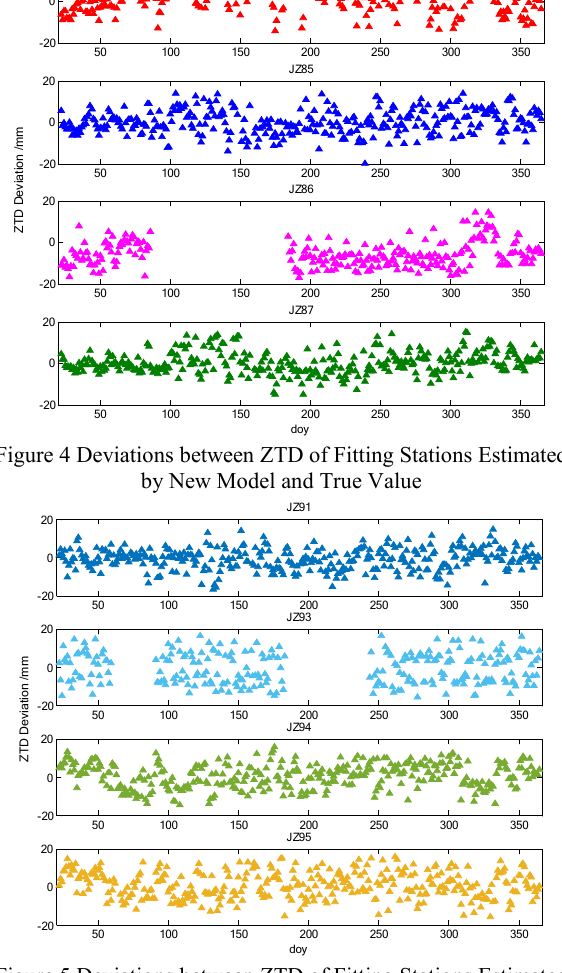
Figure 5 Deviations between ZTD of Fitting Stations Estimated by New Model and True Value